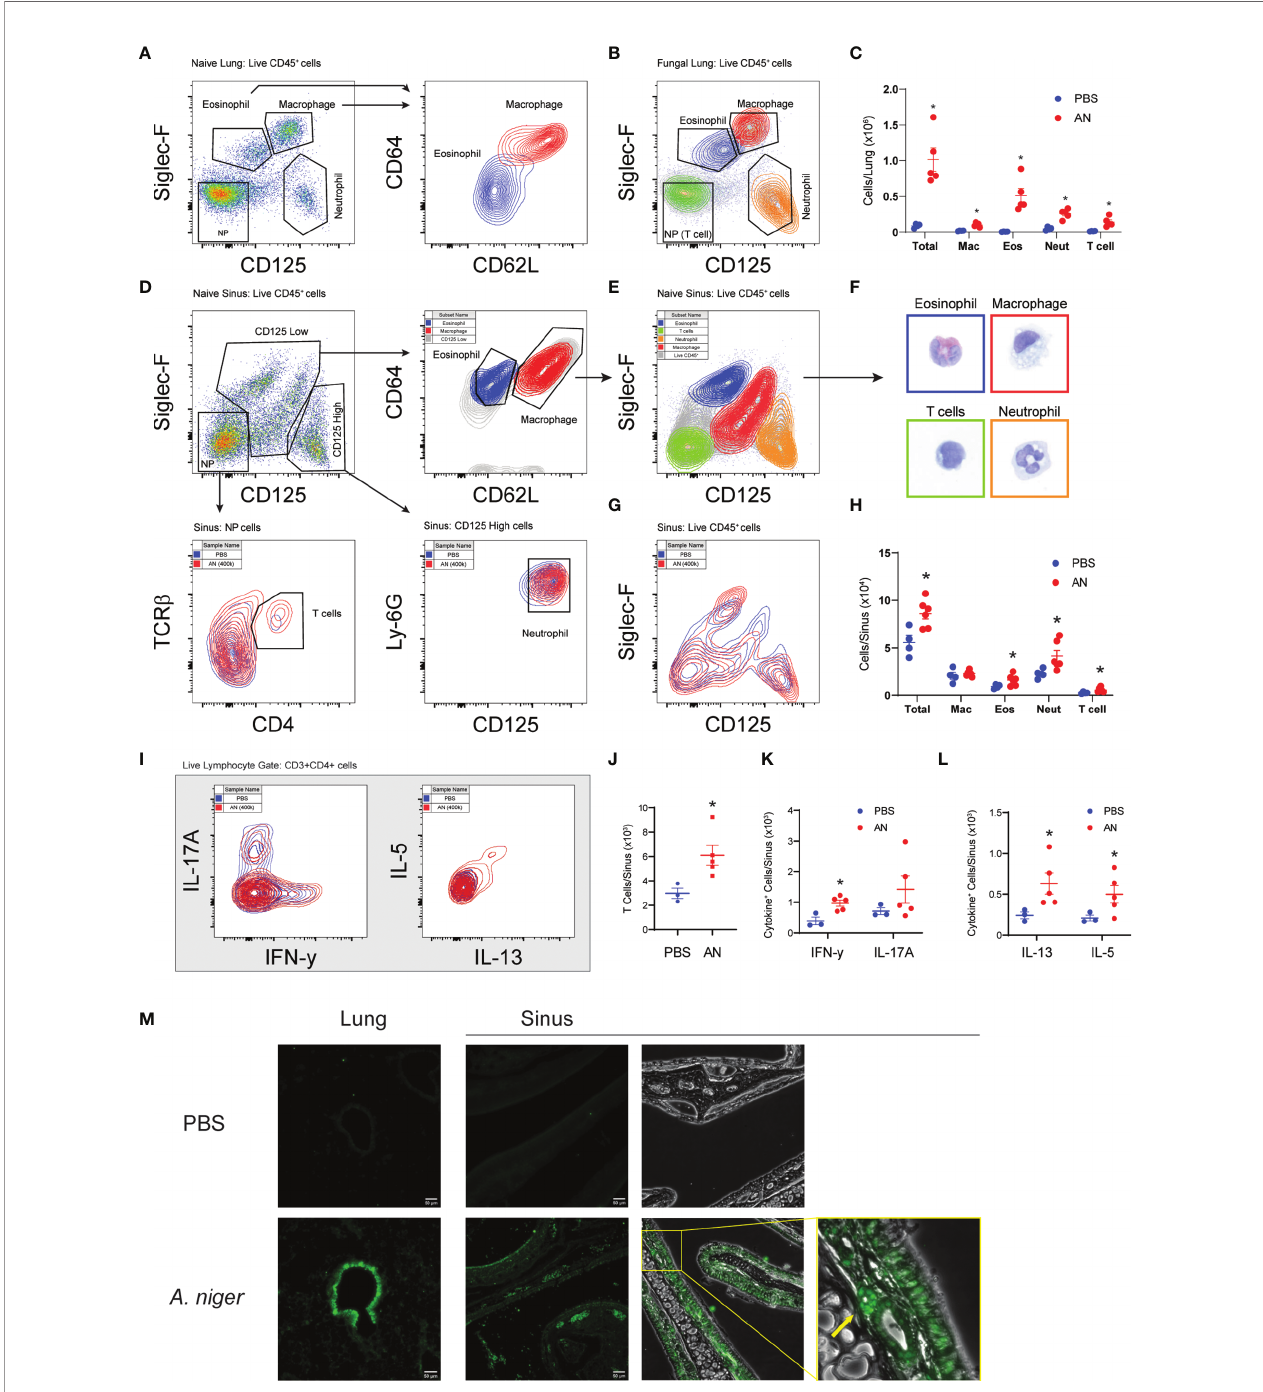
FIGURE 2 | Airway mycosis induces eosinophilic, TH2-high in fl ammation in the upper and lower airways. Mice were challenged with 4 × 10 5 A. niger (AN) or PBS daily for 2 months. Representative fl ow plots of lung single cell suspensions from (A) PBS or (B) fungal challenged (AN) wild-type C57BL/6 mice, with gates for eosinophils (Eos), macrophages (Mac), neutrophils (Neut), and TCR b +CD4+ T cells in the negative population (NP), and sub-gates for Eos/Mac. (C) Differential cell counts from lungs. (D) Representative fl ow plots of naïve sinus, showing gating scheme for differential cell analysis and (E) sorting of cells for direct (F) imaging of H&E-stained cells (border colors match sorted population). (G) Overlay of fungal and PBS-treated mice and (H) differential cell counts of sinus in fl ammatory cells. (I) Representative fl ow plots of ex vivo stimulated TCR b +CD4+ T cell cytokine production from sinuses was analyzed, with (J) total T cells, (K) IFN- g + and IL-17+, and (L) IL-13+ and IL-5+ cells quanti fi ed. (M) Fluorescent immunohistochemical staining of mouse sinus after PBS and A. niger challenge showing distribution of major basic protein, yellow box and arrow highlighting an eosinophil. Results presented as mean ± s.e.m. from at least two independent experiments with n = 3-5. * p < 0.05, n ≥ 3; by two-way ANOVA for differential counts and one-tailed t -test for cytokine